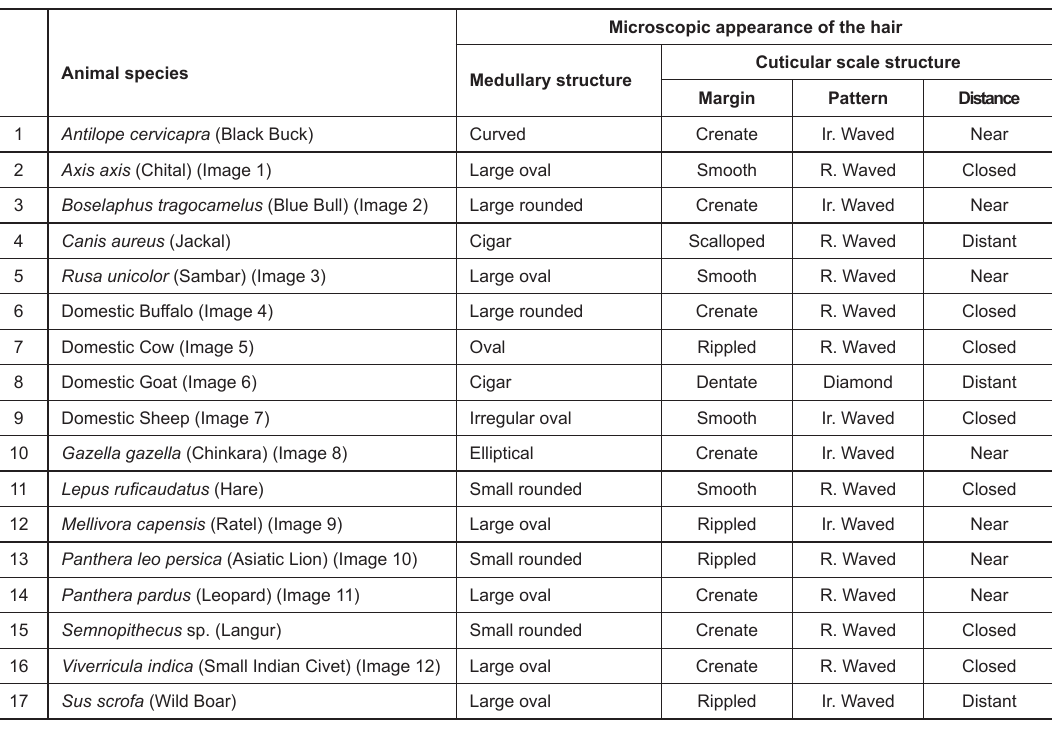
Table 2. Microscopic characteristics of mammalian hair for rapid identification